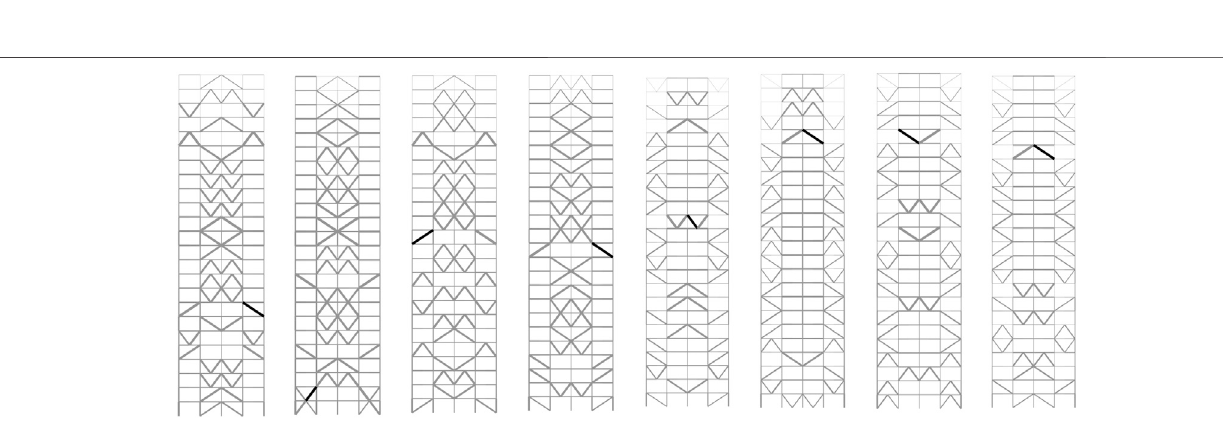
FIGURE 7 | Four best and worst solutions in 10,000 samples considering symmetry condition.